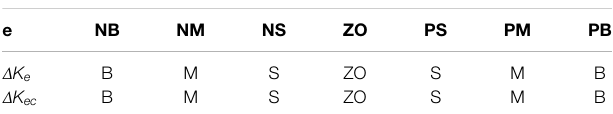
TABLE 2 | Amendment rules of Δ K e , Δ K ec .